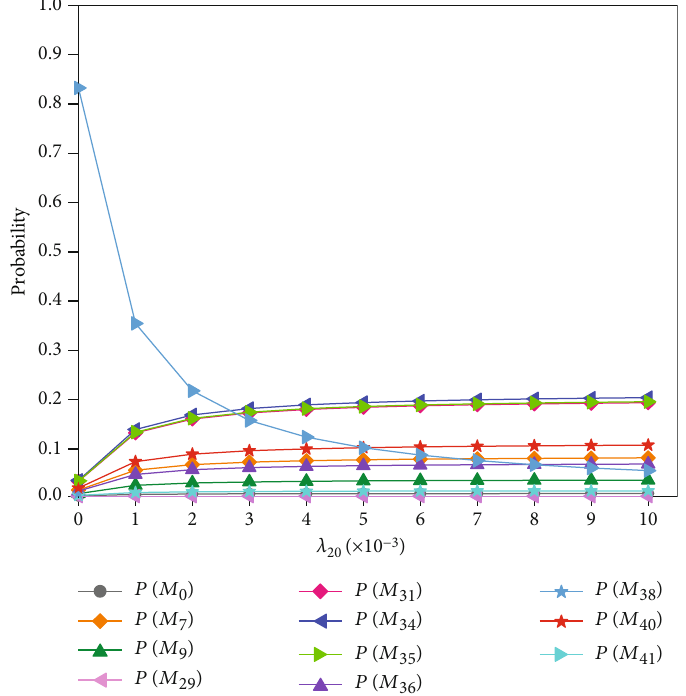
Figure 11: Variation of system probability with change in λ